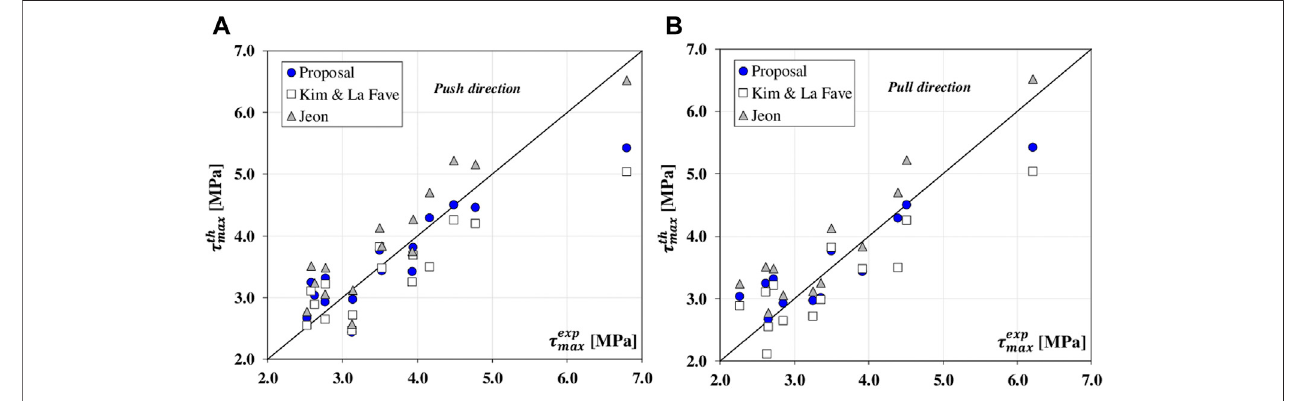
FIGURE 7 | Numerical vs experimental τ max values: comparisons between the new proposal and Models 1 & 5: push loading direction (A) ; pull loading direction (B) .